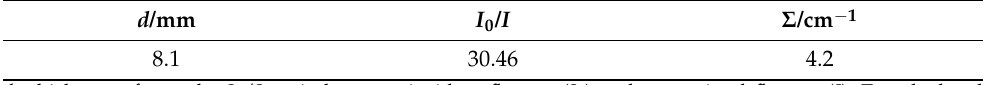
Table 6. Summary of thermal neutron absorption measurement.